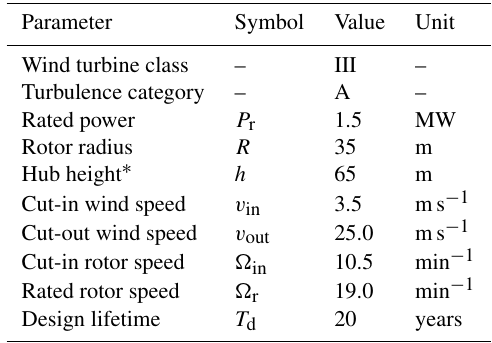
Table 2. Design parameters of the Südwind S70 turbine